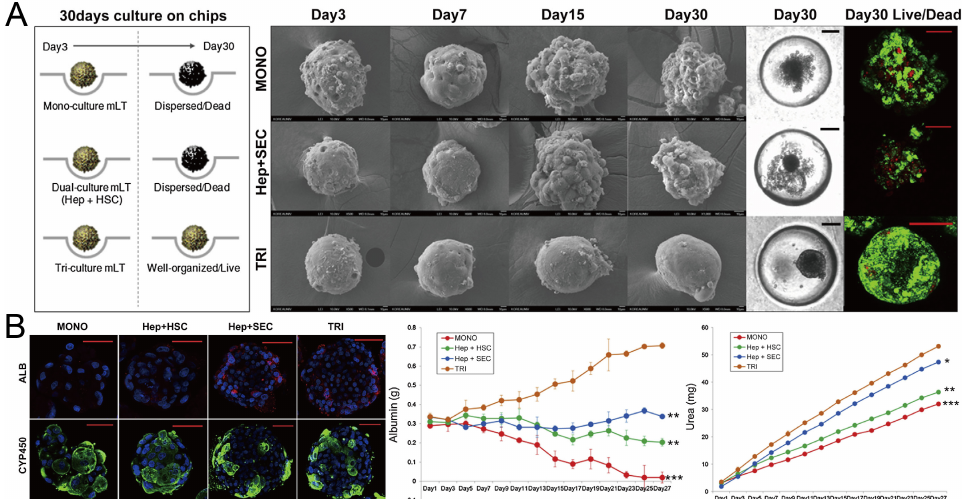
Figure 16. Formation of hepatic spheroids by different culture modes, and the comparison of their secretion of albumin and urea [92]. ( A ) Culture of spheroids by mono-culture of hepatocytes, co- culture of hepatocytes and hepatic stellate cells, tri-culture of hepatocytes, hepatic stellate cells and sinusoidal endothelial cells over time. Black scale bars: 100 µm, red scale bars: 50 µm. ( B ) Different spheroids with serum albumin (red), CYP450 reductase (green) and nuclei (blue) stained (left), and the secretion of albumin (middle) and urea with time (right). * p < 0.05, ** p < 0.01, *** p < 0.001. Scale bars: 50 µm. Reprinted (adapted) from [92]. Copyright (2014) with permission from